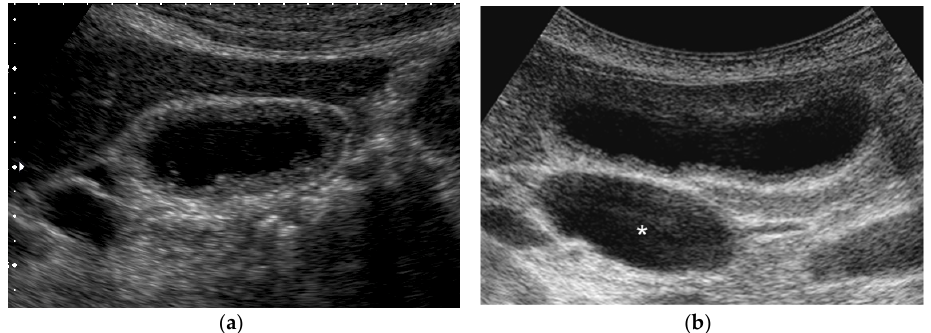
Figure 11. Diffuse GWT without IHL in pancreaticobiliary maljunction (PBM). US showed thicken- ing of the inner hypoechoic layer without the presence of IHL and outermost hyperechoic layer. ( a ) PBM without biliary dilatation, ( b ) PBM concomitant with biliary dilatation (*: dilated extrahepatic bile duct).